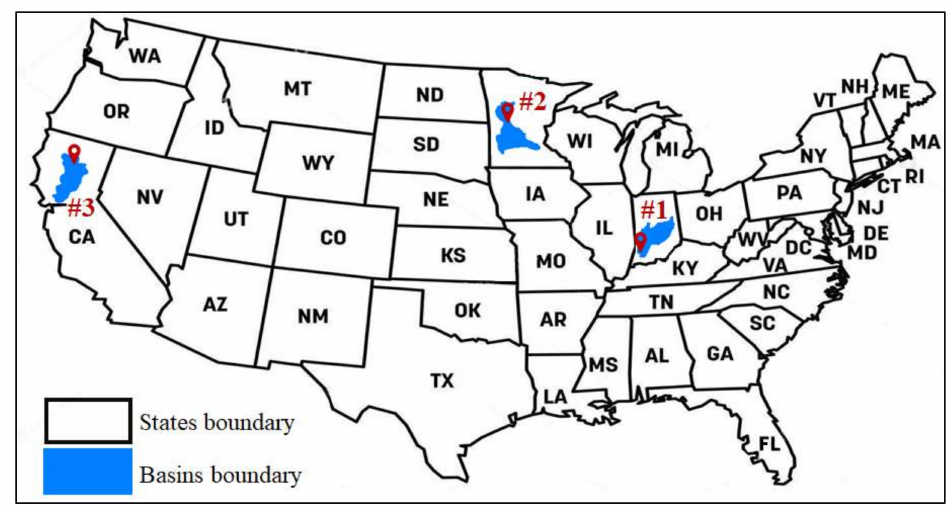
Figure 3. Location of 3 study basins in different climate regions across the United States.